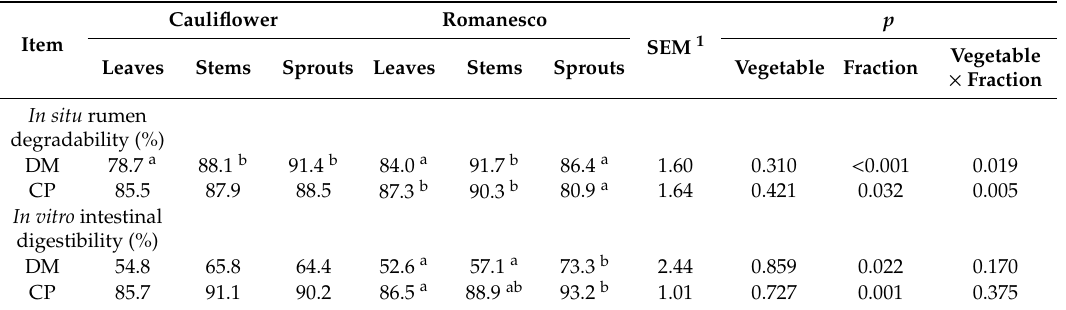
Table 4. Rumen degradability after 12 h of in situ incubation and in vitro intestinal digestibility of dry matter (DM) and crude protein (CP) of di ff erent fractions of cauliflower and Romanesco.